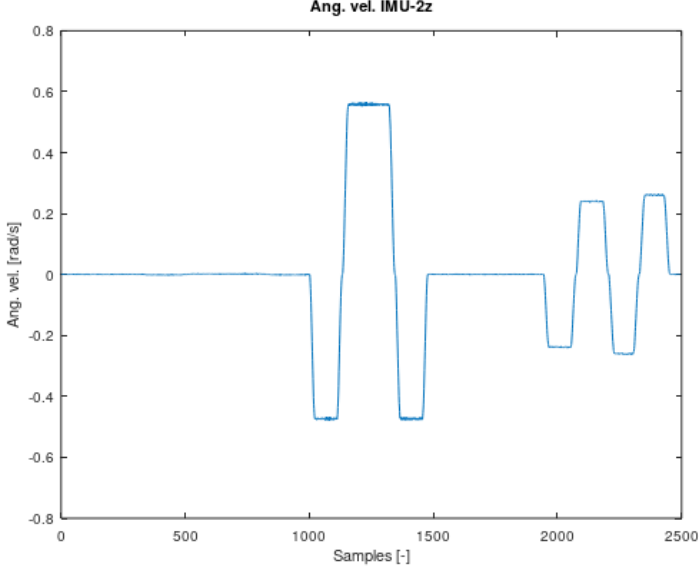
Figure 9. The angular velocity value for the axis Z IMU-2.